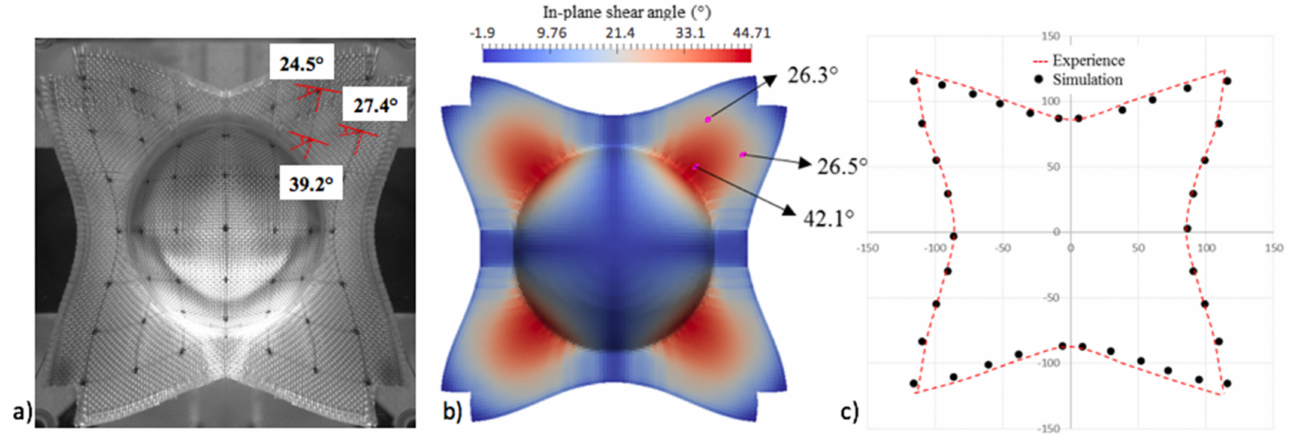
Figure 3. Comparisons between the experimental and numerical results for hemispherical forming. ( a , b ) In-plane shear angle in the same position. ( c ) Deformed